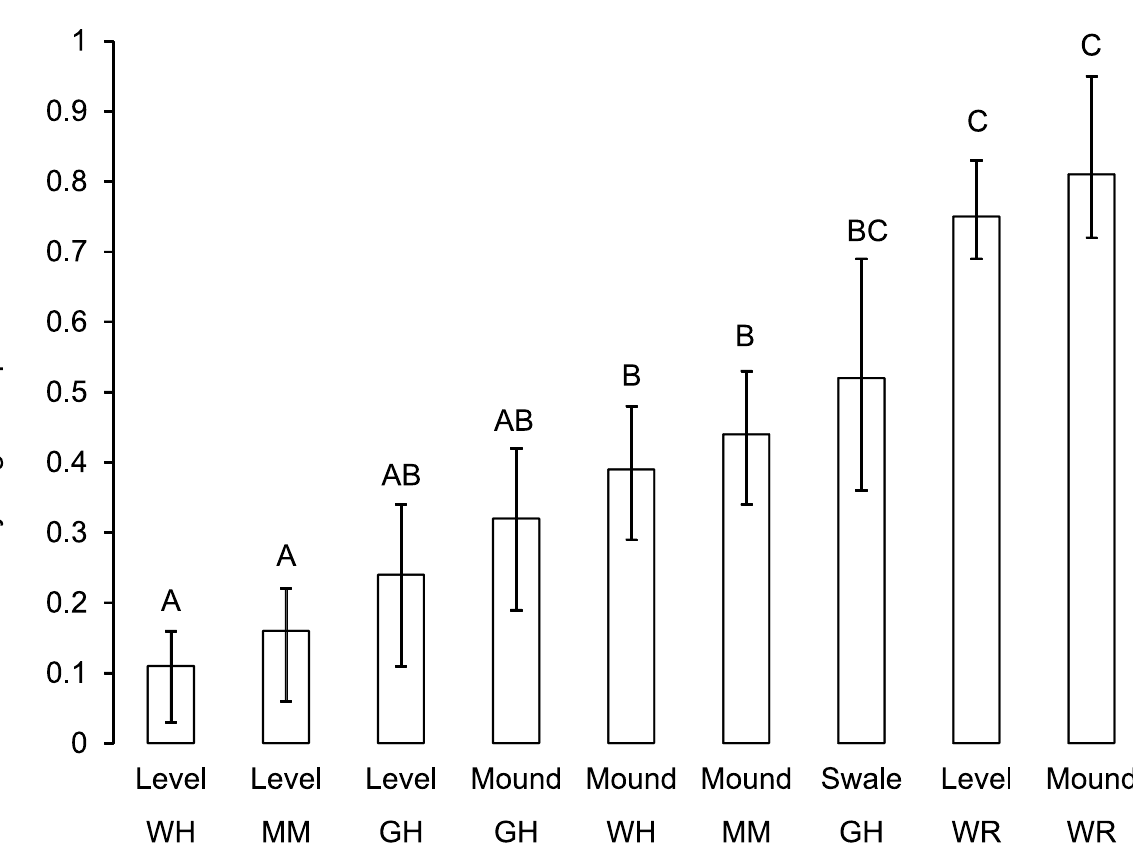
Fig 4. The influence of prairie and topography on the probability of golden paintbrush survival after 5 years at four prairies with topographic heterogeneity (GH = Glacial Heritage, MM = Mima Mounds, WH = Wolf Haven, WR = West Rocky). Error bars represent 95% confidence intervals. Different letters represent significantly different probabilities of survival ( α (cid:3)